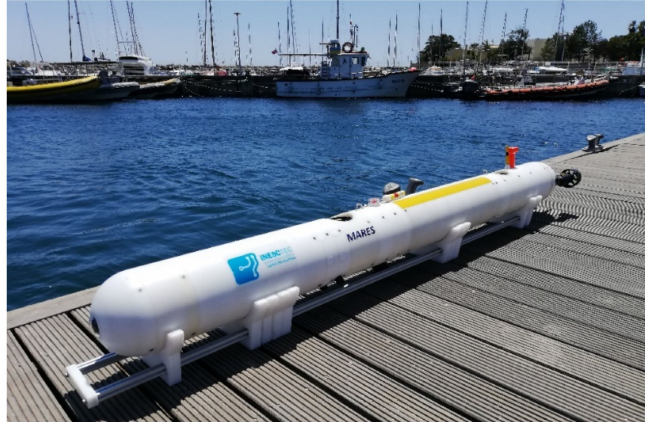
Figure 1. MARES AUV built using modular